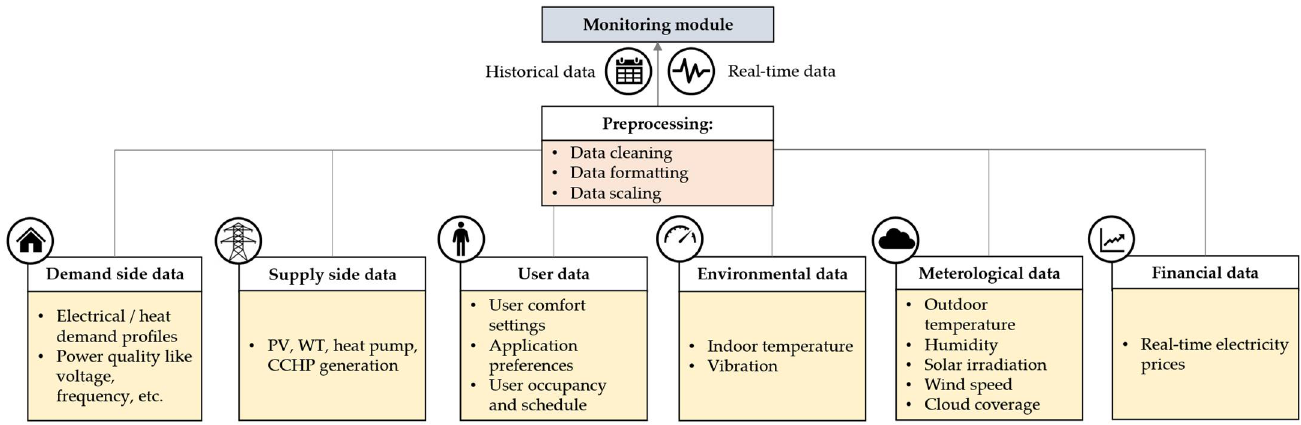
Figure 3. Real-time and historical data for energy management systems .